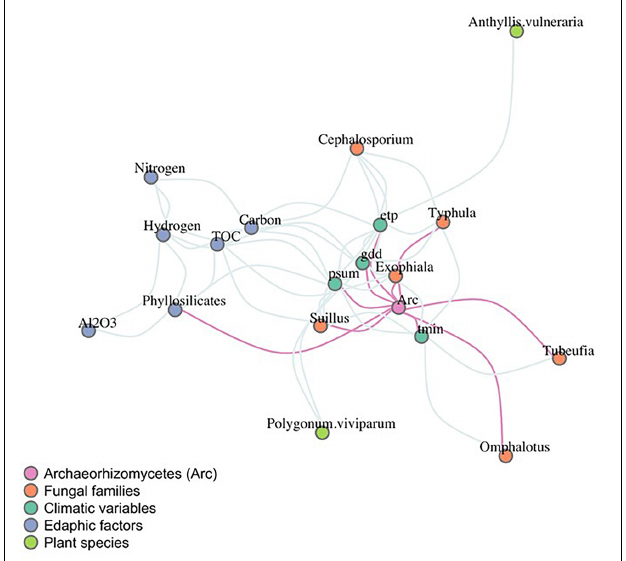
FIGURE 4 | Inference network of co-occurrences between Archaeorhizomycetes, biotic, climatic, and abiotic variables. Nodes are colored according to the variable type as indicated in the color legend. Direct connections to Archaeorhizomycetes in pink represent the significant predicted relationships using the pseudo p -values. Tmin, minimum monthly average temperature; gdd, growing degree-days; etp, potential evapotranspiration; TOC, total organic carbon; psum, sum precipitation days/growing